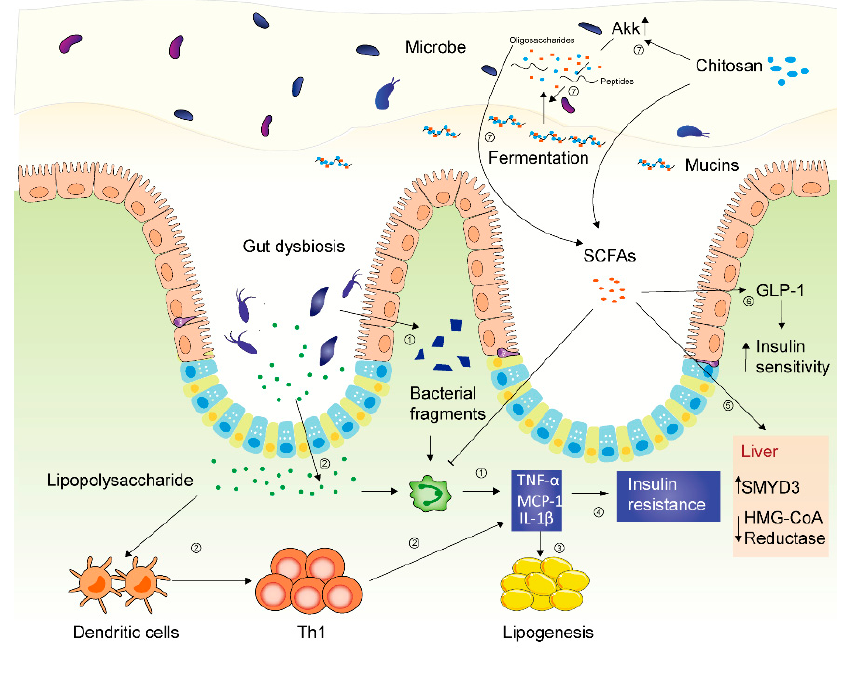
Figure 3. Mechanisms of chitosan in gut microbiota modulation in metabolic syndrome. ① Gut dysbiosis leads to bacterial fragment influx into blood circulation, inducing increased proinflammatory cytokines. ② Gut dysbiosis causes influx of lipopolysaccharides, which activates dendritic cells. Activated dendritic cells promote Th growth, resulting in increased proinflammatory factors (e.g., TNF- α , MCP-1, IL-1 β ). ③ Proinflammatory cytokines promote lipogenesis. ④ TNF- α induces insulin resistance through inhibition of sensitivity of insulin receptors. ⑤ SCFAs, metabolites of chitosan, inhibit HMG-CoA Reductase by overexpressing